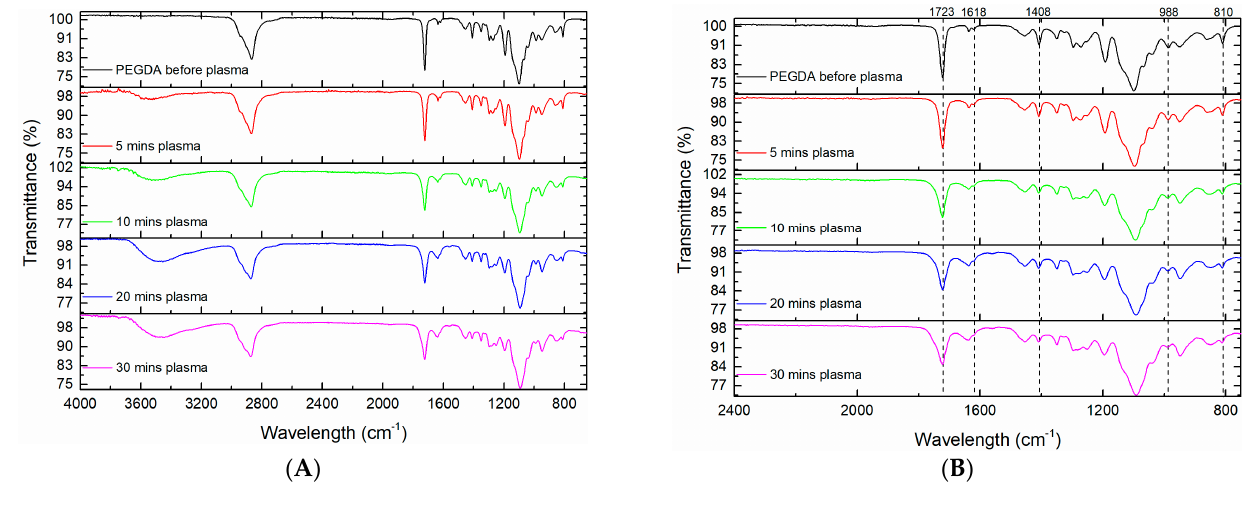
Figure 2. FT ‐ IR spectra of PEGDA before and after several DBD plasma treatment times. ( A ) The full range of the FT ‐ IR spectra taken. ( B ) The x ‐ axis has been truncated to better show the annotated bands of interest.